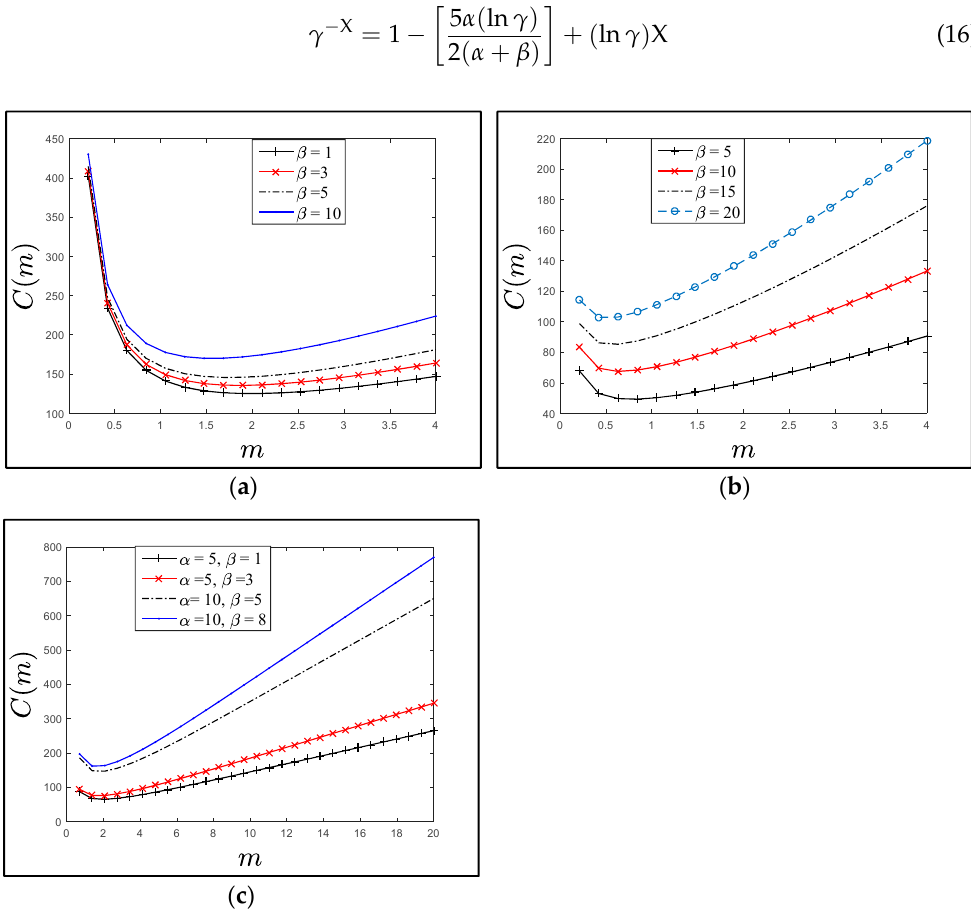
Figure 9. The C ( m ) values when the residence time is exponentially distributed with mean μ − 1 . ( a ) The C ( m ) values when α = 10, β ≤ α . ( b ) The C ( m ) values when α = 5, β ≥ α . ( c ) The C ( m ) values when α = 5,10, β ≤ α